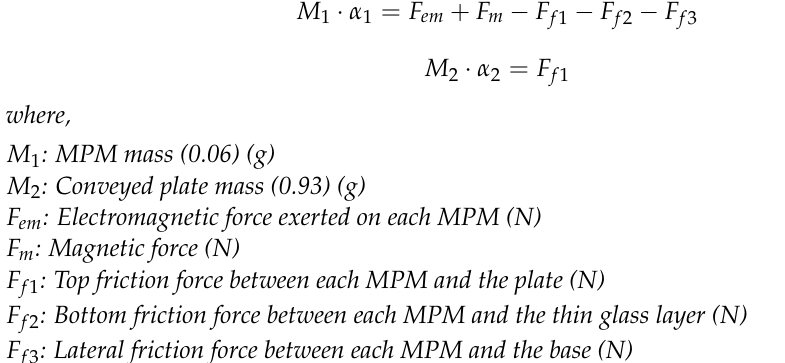
) can be calcu ‐ (cid:2869)